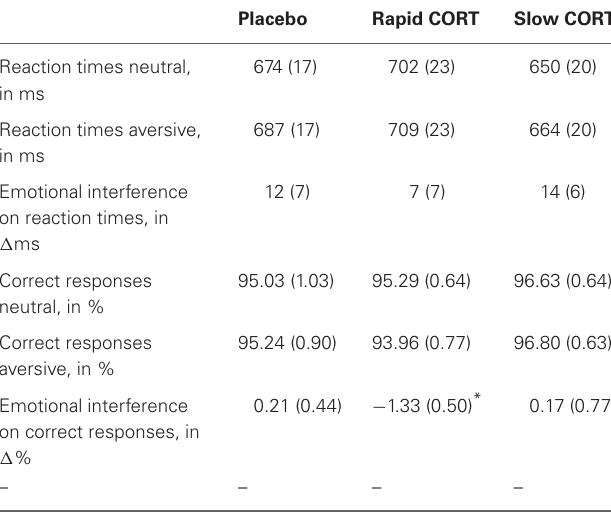
Table 1 | Behavioral performance on the emotional interference